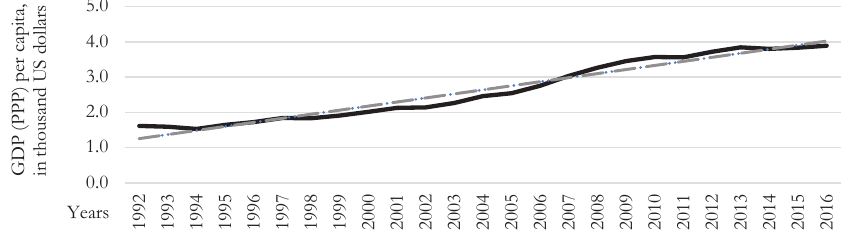
Fig. 10 – The GDP (PPP) dynamics of 25% of the poorest countries in the world. Source: own